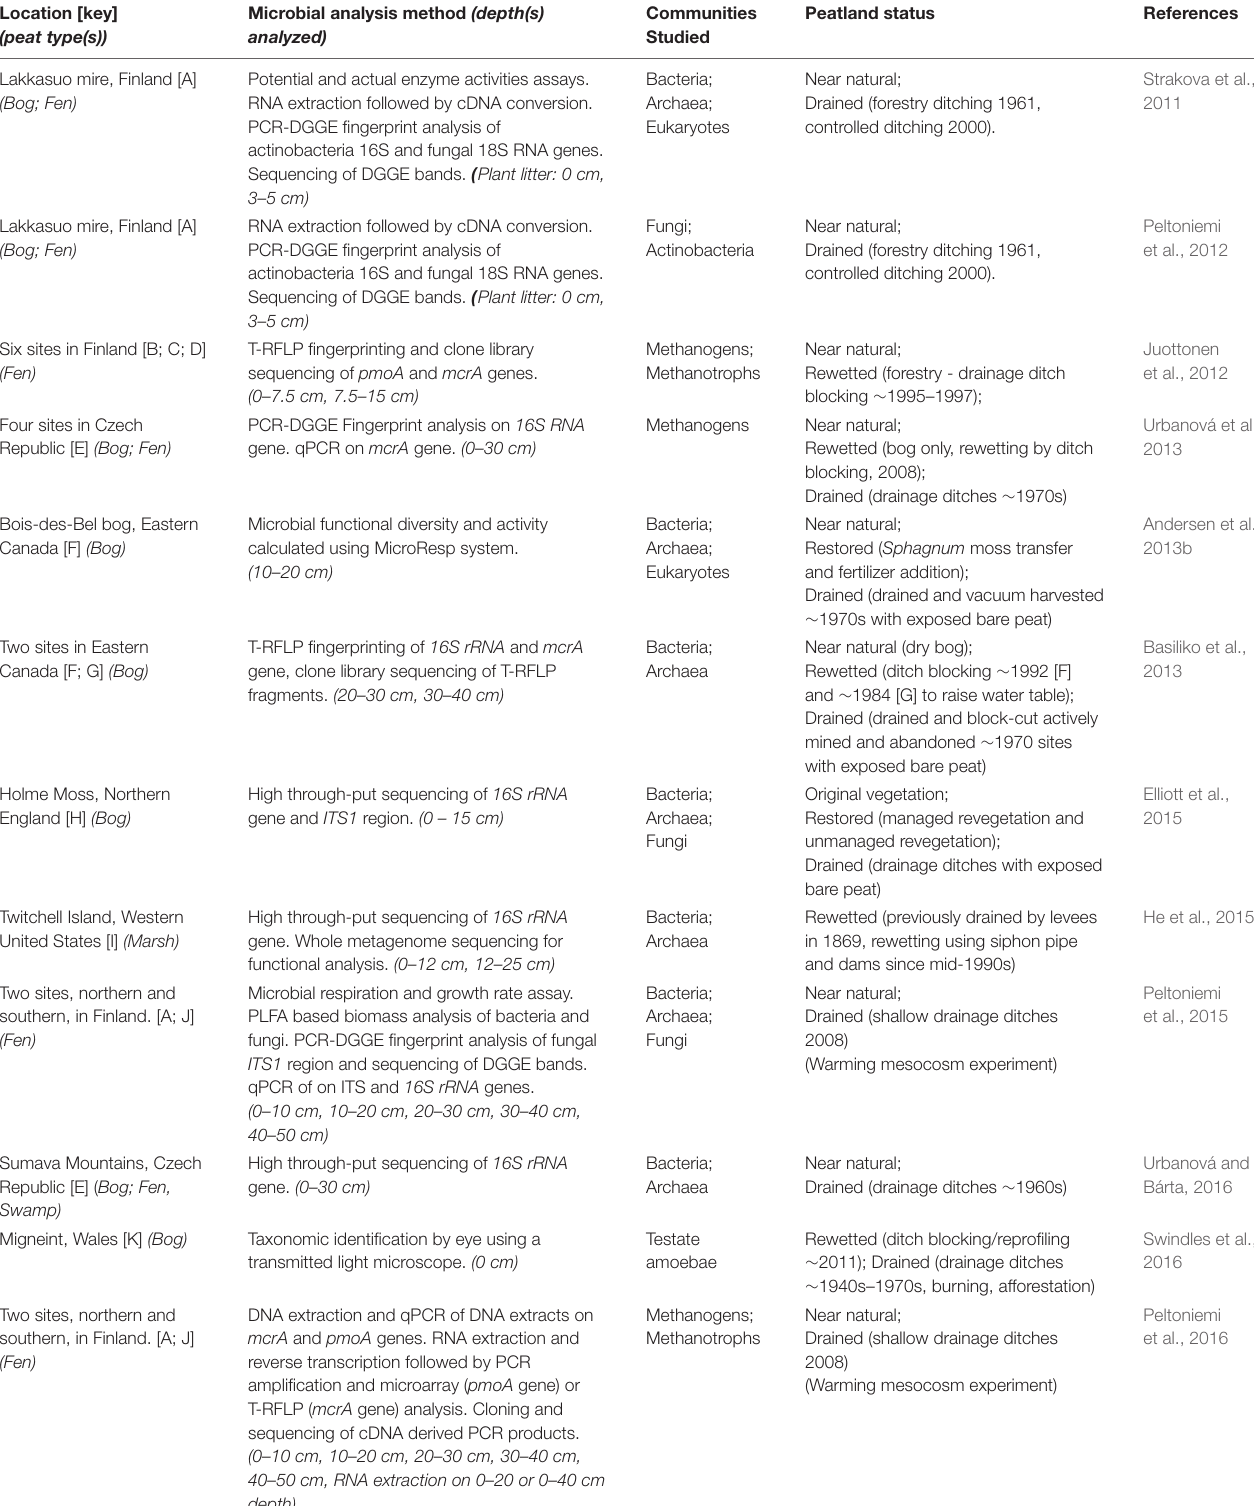
TABLE 1 | 21 Studies investigating the response of microbial communities to peatland drainage and rewetting. Location [key] (peat